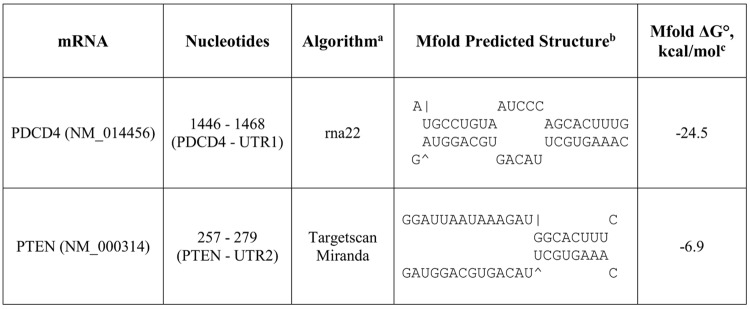
Predicted miR-17-5p guide strand binding sites in the 3'UTR of PDCD4 and PTEN mRNAs.
aThe potential oncomiR:mRNA binding sites were identified by rna22, Targetscan, or miRanda. bTop strand is mRNA (5' ➔ 3') and the bottom strand is oncomiR (3' ➔ 5'). cCalculated at http://mfold.rna.albany.edu/?q=mfold.